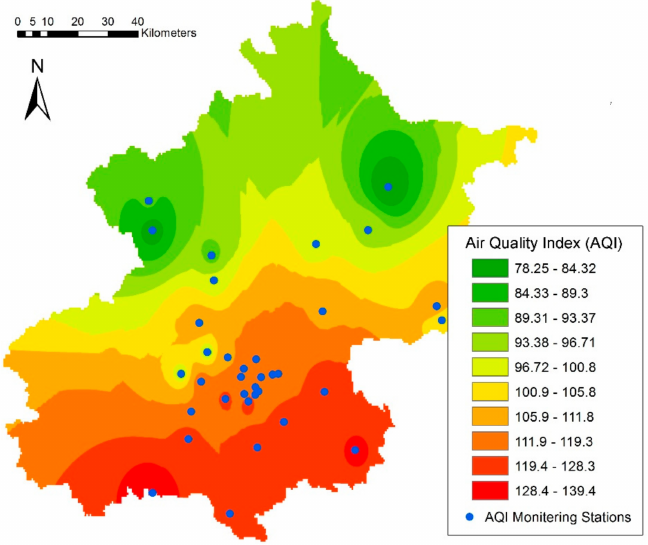
Figure 2. The distribution of AQI and monitoring stations in Beijing